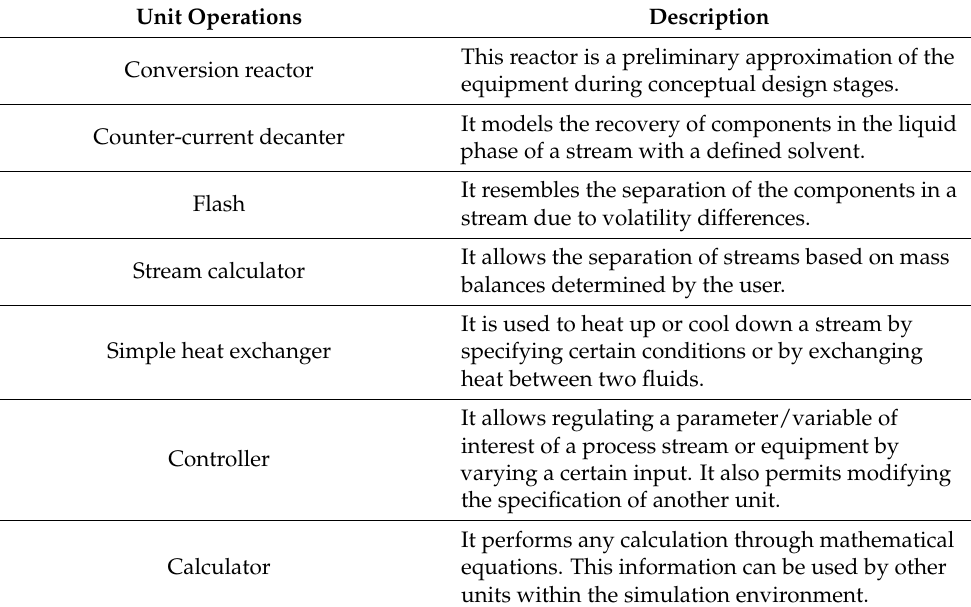
Table 2. Unit operations incorporated into the process simulations in